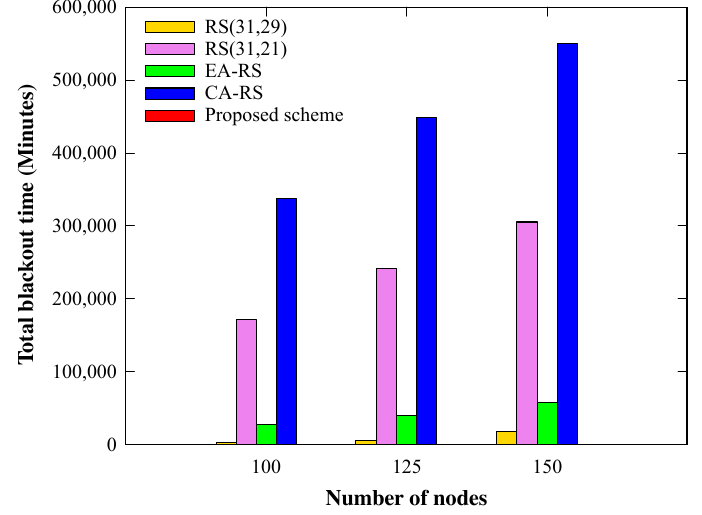
Figure 12. Total number of blackout nodes with various node counts (BER